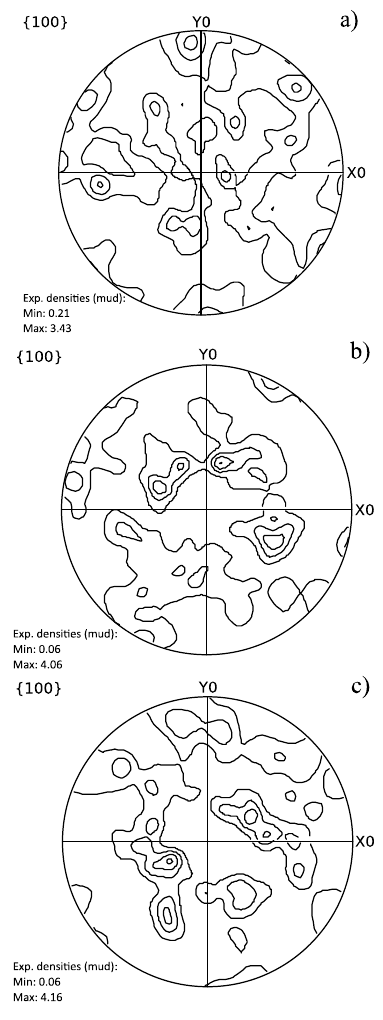
Figure 9. {100} pole figures of ( a ) CR60; ( b ) CR100 and ( c ) Reference samples with the rolling direction parallel to Z0. parallel to